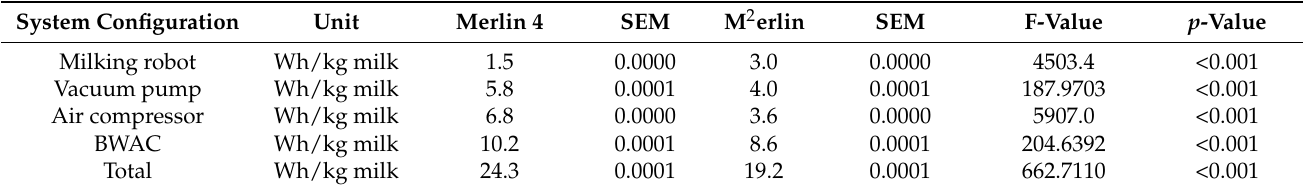
Table 5. Daily energy consumption of the different energy consumers and the total AMS systems related to the milk